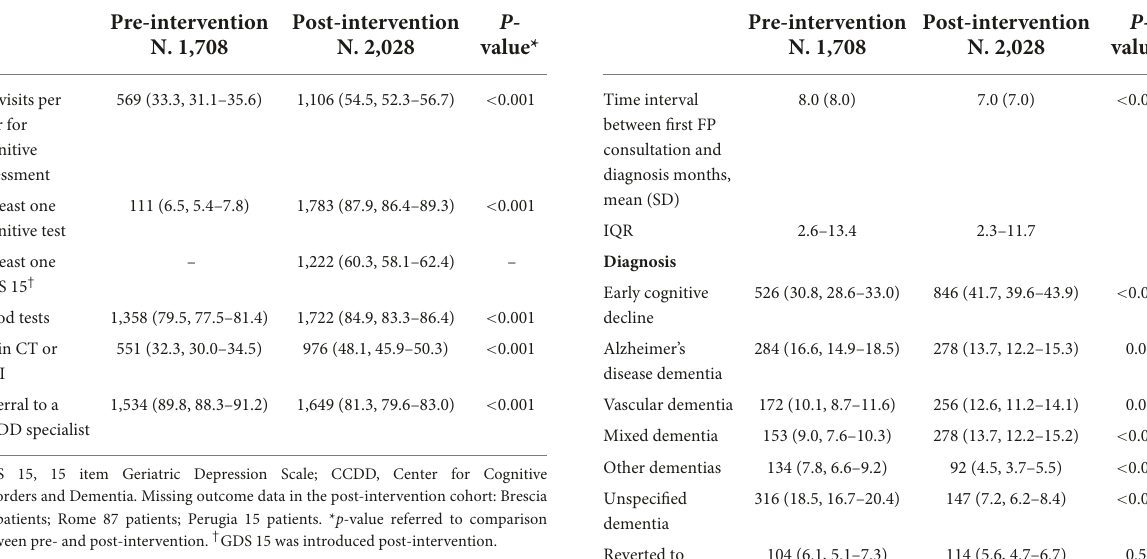
TABLE 3 Time interval between first FP consultation and diagnosis of cognitive decline, and number (%, 95% CI) of diagnosis during follow-up, in the pre- and